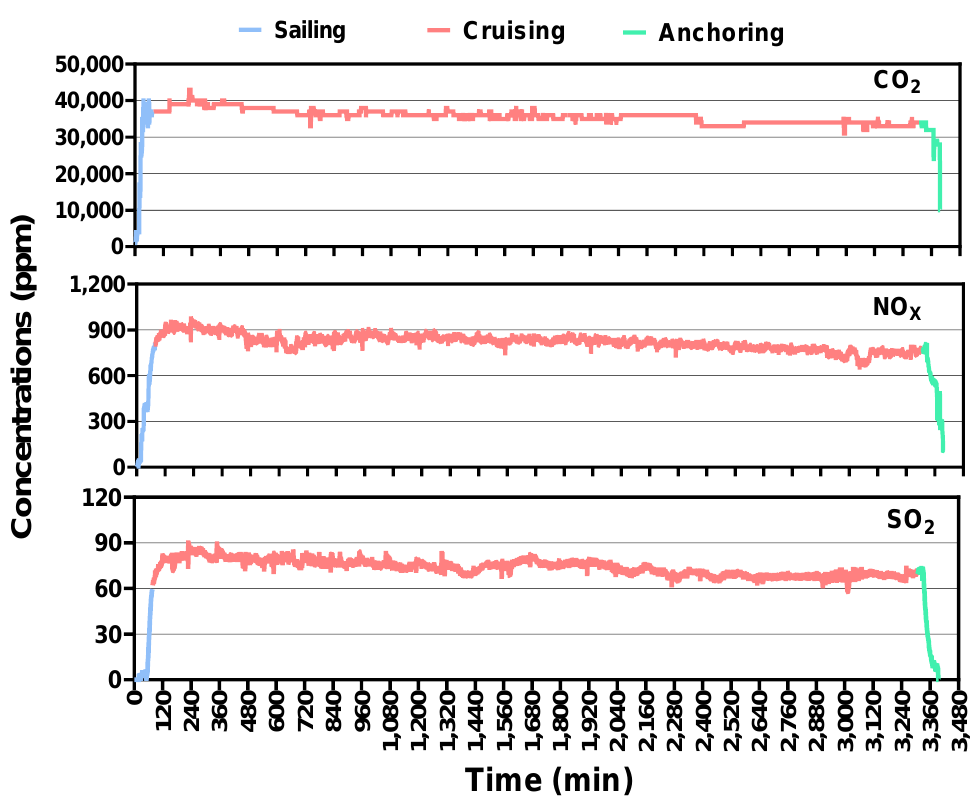
Figure 3. Instantaneous-emission concentrations of contaminants in the ship exhaust gas.